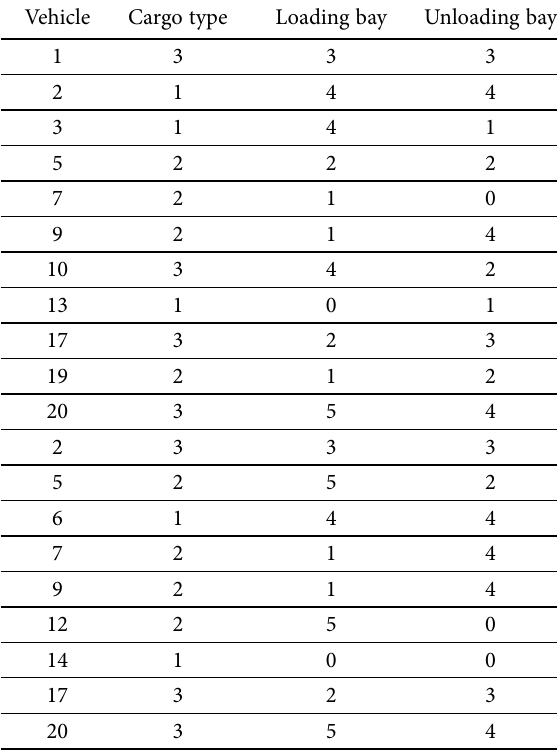
Table 1. Example of the vehicles’